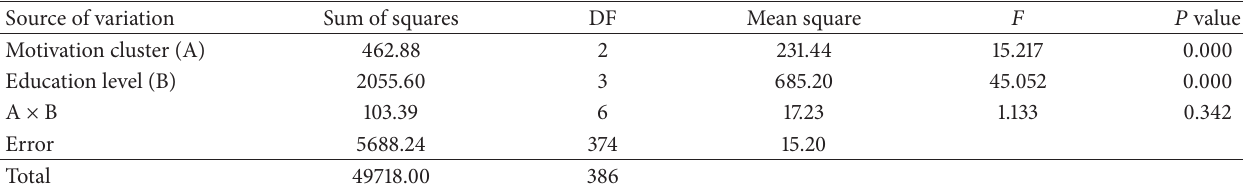
Table 4: Two-way ANOVA table for mathematics performance with motivation cluster and the educational level as independent variables ( 𝑁 = 386).